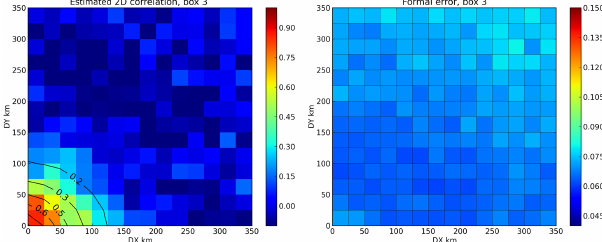
Figure 5. 2-D covariance calculated in a 20 ◦ × 60 ◦ area (box num- ber 3) in the North Pacific Ocean (left) and associated formal error (right) for temperature at 1000m. Black isolines (left) correspond to the adjusted covariance model.